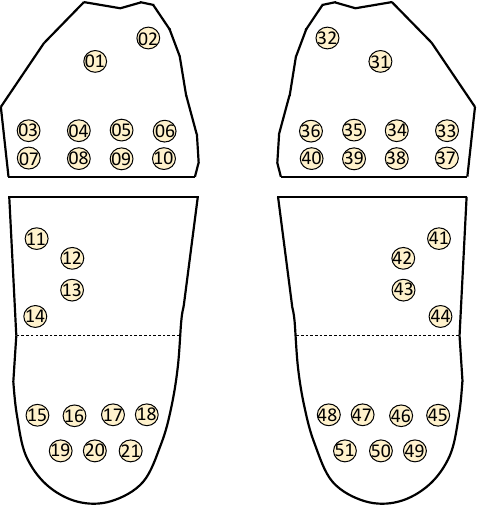
Figure 4. Sensor positions for left and right feet.